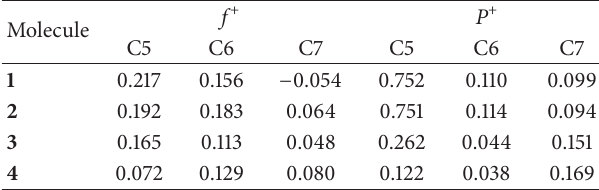
Table 3: Fukui ( 𝑓 + ) and Parr ( 𝑃 + ) functions for the nucleophilic attack at carbons 5, 6, and